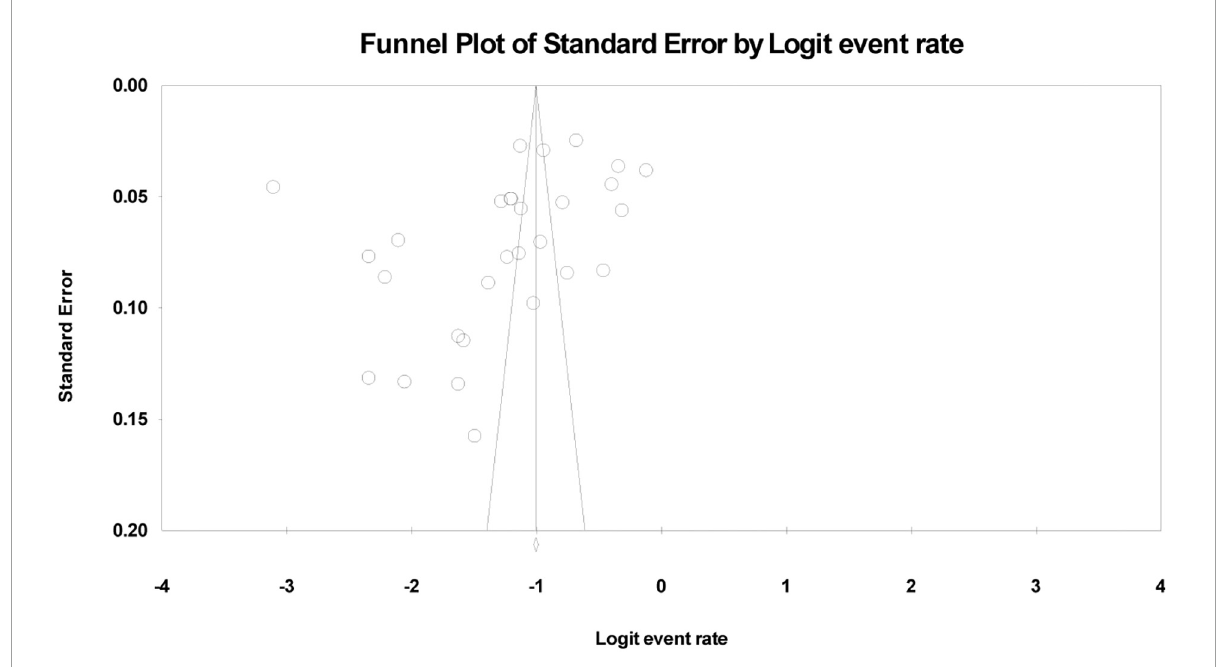
FIGURE4 Funnel plot of the lifetime aggregate prevalence of non-suicidal self-injury (NSSI) in adolescents.